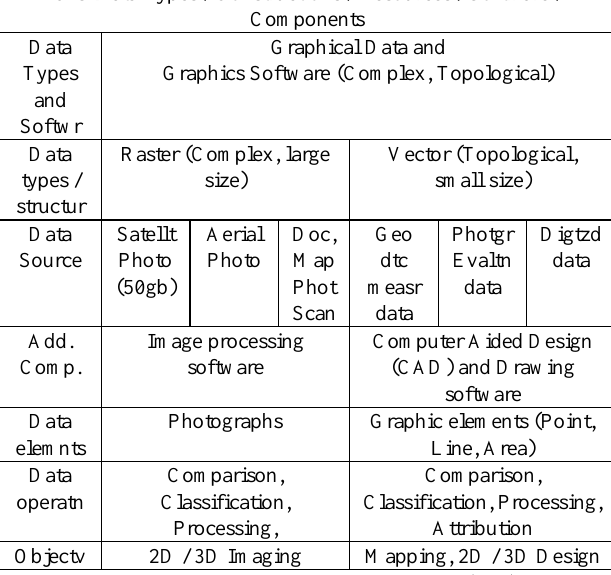
Table 9. Geographic Information Systems (GIS)